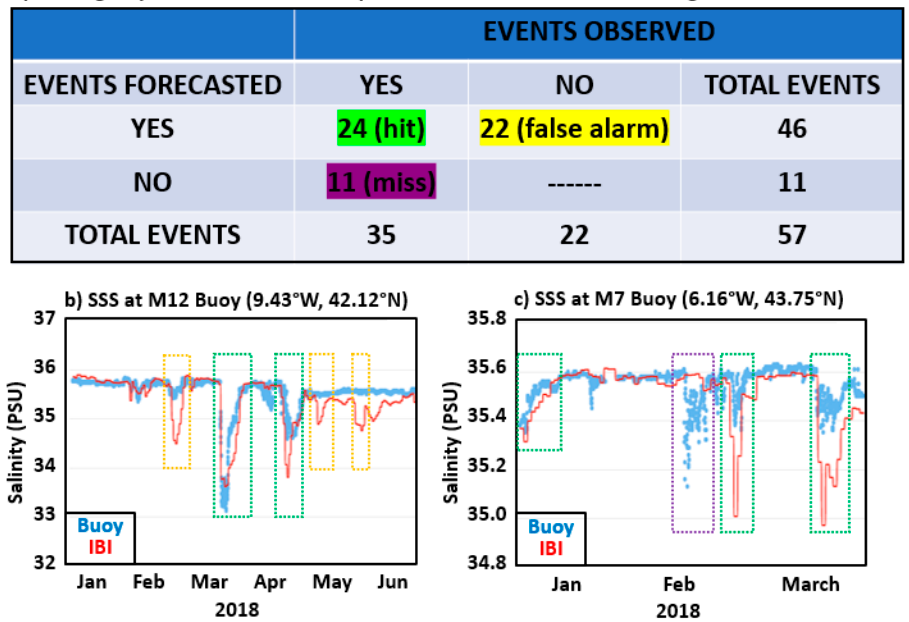
Figure 5. ( a ) Contingency table focused on significant sea surface salinity (SSS) drops detected during 2018 at coastal buoys moored around the Iberian Peninsula (buoys M2–M12 used, see Figure 2 for location). Hit, miss and false alarm events are highlighted in green, purple and yellow colors, respectively. ( b ) Six-month observed (blue dots) and IBI modeled (red line) SSS timeseries at Silleiro buoy (M12). Relevant SSS drops marked with colored dashed squares. ( c ) Three-month timeseries comparison of SSS observed at Cabo de Peñas buoy (M7) and modelled by CMEMS-IBI at the closest grid point.